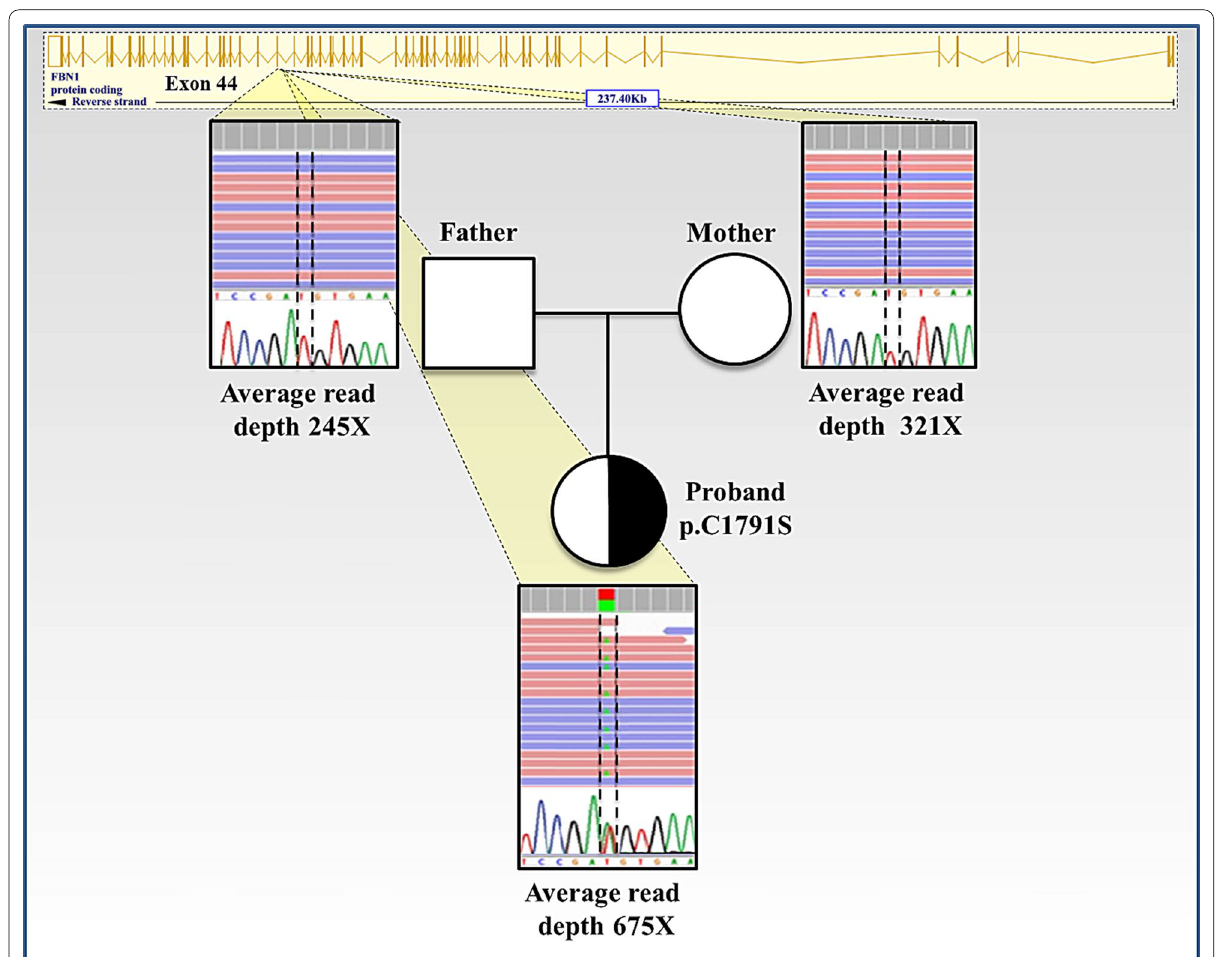
Fig. 1 Diagram of the pedigree tree for the missense c.5371 T > A mutation in the FBN1 gene. IGV software (Integrative genomics viewer) displays FBN1 genotypes for the father (T/T), mother (T/T), and proband (A/T), with validation using Sanger